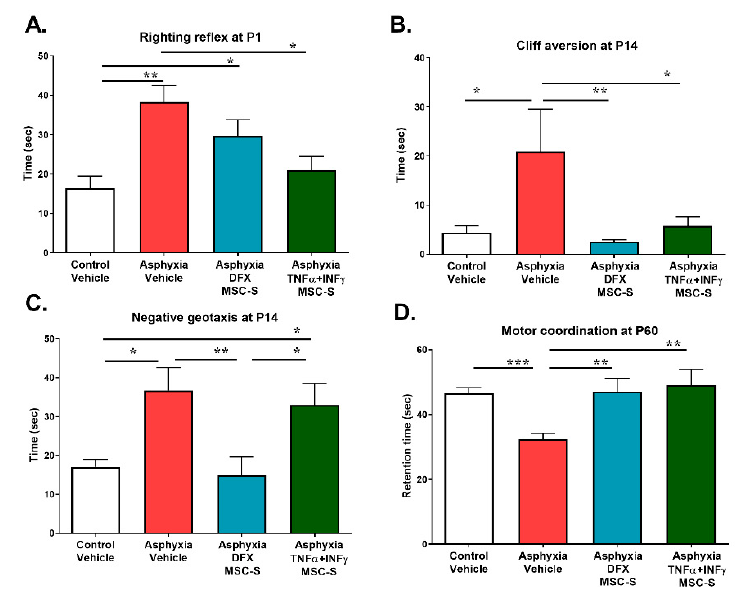
Figure 7. E ff ect of intranasal administration of DFX- or TNF- α + IFN- γ -MSC-S on the behavioral outcome induced by PA. Schematic representation of intranasal administration of vehicle or MSC-S and evaluation schedule are shown in Supplementary Figure S2. ( A ) Righting reflex: rats were placed in a supine position and the time elapsed in seconds to turn over to a prone position, standing on all four paws, was recorded for control (CS, white bar) and asphyxia-exposed rats (AS, red bar) at P1, intranasally treated with vehicle, DFX-MSC-S (cyan bar), or TNF- α + IFN- γ -MSC-S (green bar). Data represent means ± SEM. Kruskal-Wallis test, ** p < 0.05, Benjamini, Hochberg, and Yekutieli post-hoc: * * p < 0.005; CS v / s AS, * p < 0.05; AS v / s Asphyxia- (TNF- α + IFN- γ )-MSC-S, * p < 0.05; CS v / s asphyxia-DFX-MSC-S, * p < 0.05; AS v / s Asphyxia-TNF α + IFN- γ -MSC-S; N = 38–35 samples per group. ( B ) Cli ff aversion: the rat was placed with its forelimbs and head on the edge of a raised surface 30 cm from the floor for 30 s. The time at which the rat turned away from the cli ff and moved its paws and head away from the edge was recorded at P14. Data represent means ± SEM. Kruskal-Wallis test, * p < 0.05, using Benjamini, Hochberg, and Yekutieli as post-hoc test: * p < 0.05; CS (white bar) v / s AS (red bar), ** p < 0.005; AS v / s Asphyxia-DFX-MSC-S (cyan bar), * p < 0.05; AS v / s Asphyxia-TNF α + IFN- γ -MSC-S (green bar), N = 7–9 samples per group. ( C ) Negative geotaxis: the rat was placed facing down on a slope (30 ◦ ). The hindlimbs of the pups were placed in the middle of the slope. The time in which the rat turned to face up the slope and climbed up with its forelimbs reaching the upper rim was recorded at P14. Data represent means ± SEM. Kruskal-Wallis test ** p < 0.005, followed by Benjamini and Hochberg, and Yekutieli post-hoc: * p < 0.05, CS (white bar), * p < 0.05; CS v / s Asphyxia-TNF α + IFN- γ -MSC-S (green bar), ** p < 0.005; AS v / s Asphyxia-DFX-MSC-S (cyan bar), ** p < 0.005; Asphyxia-DFX-MSC-S v / s Asphyxia-TNF α + IFN- γ -MSC-S, N = 5–8 per group. ( D ) Motor coordination: At P60, the rat was placed on a rotarod apparatus perpendicular to a rod axis, with its head facing in the opposite direction to the rotation around the rod’s axis. Trials ended once the rat had fallen and the time spent on the rod was recorded (retention time). Data represent means ± SEM. Kruskal-Wallis test, *** p < 0.0005, followed by Benjamini, Hochberg, and Yekutieli post-hoc: *** p < 0.0005, CS (white bar) v / s AS (red bar), ** p < 0.005; AS v / s Asphyxia-DFX-MSC-S (cyan bar), ** p < 0.005; AS v / s Asphyxia-TNF α + IFN- γ -MSC-S (green bar), N = 19–23 samples per